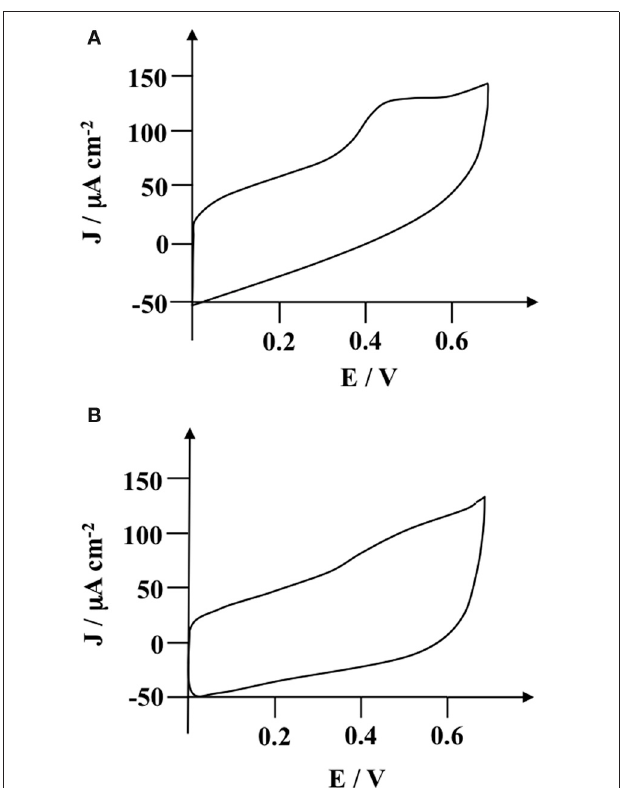
FIGURE 3 | (A) Cyclic voltammogram of the poly(pyrrole-lactosyl) film deposited on a glassy carbon electrode ( (cid:3) = 3 . 2 × 10 − 9 mol cm − 2 ) in H 2 O + 0 . 1mol L − 1 LiClO 4 ; (B) cyclic voltammogram of the poly(pyrrole-3 (cid:2) -sialyllactosyl) film ( (cid:3) = 2 . 8 × 10 − 9 mol cm − 2 ) in H 2 O + 0 . 1mol L − 1 LiClO 4 . Scan rate = 0 . 1V s − 1 .